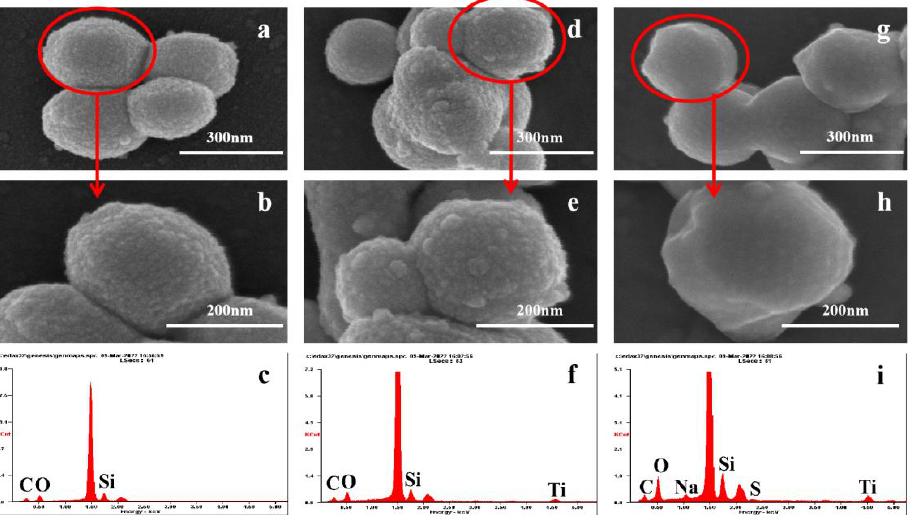
Figure 3. SEM images of ( a ) MCM − 41; ( b ) MCM − 41; ( d ) MCM − T; ( e ) MCM − T; ( g ) MCM − T − H; and ( h ) MCM − T − H. EDS spectra of ( c ) MCM − 41; ( f ) MCM − T; and ( i ) MCM − T − H.